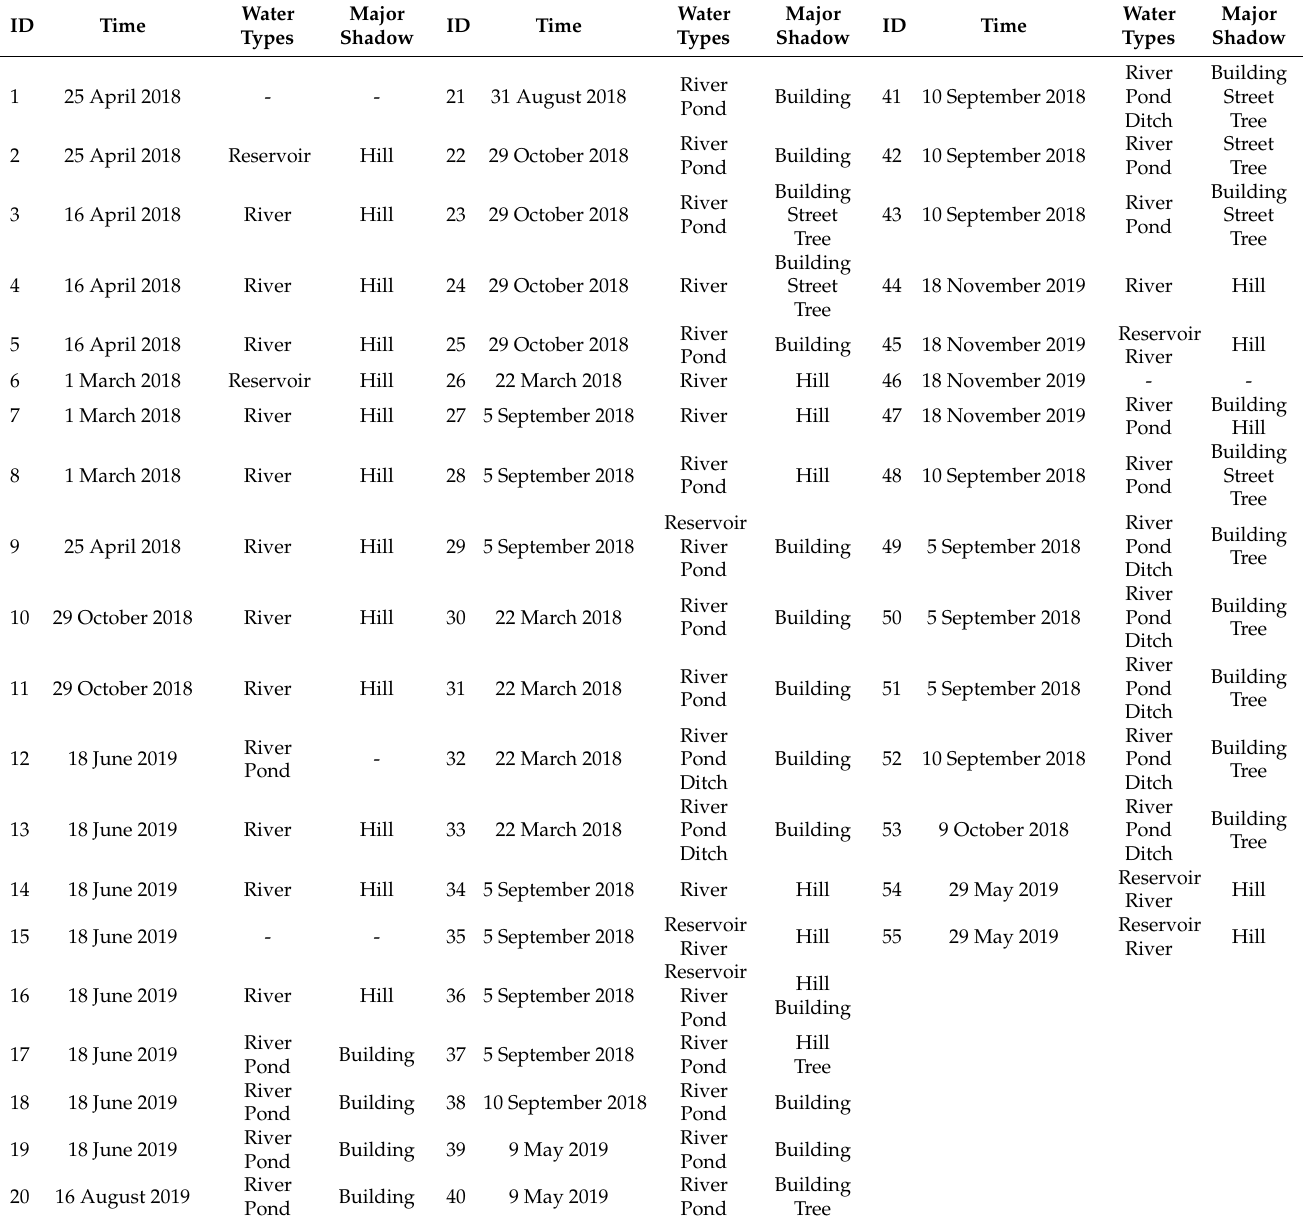
Table 1. Acquisition time, water body types, and primary shadow noise sources of the